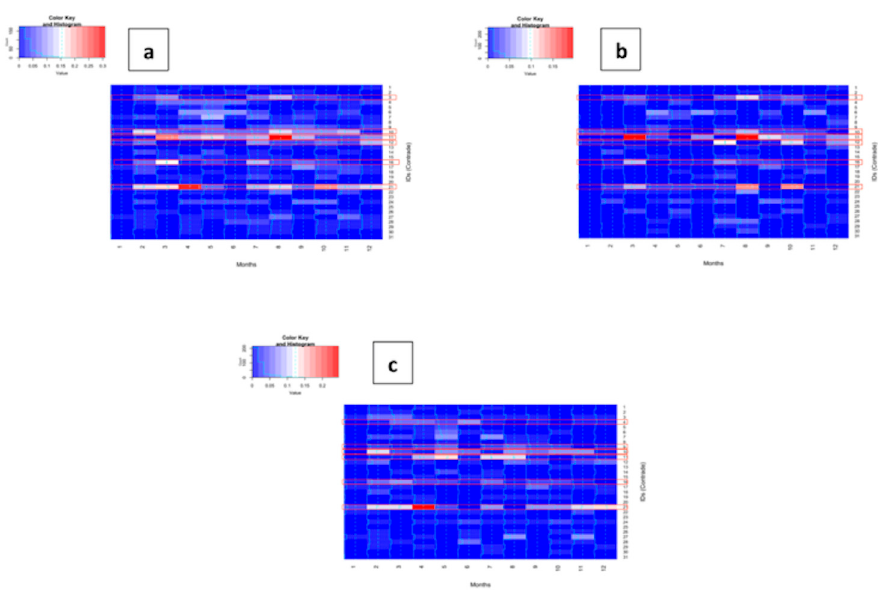
Figure 4. Heatmaps for all subjects ( a ), children ( b ), and adults ( c ). Horizontal red bands refer to the Contrade in which there were a high density of the events for the three groups of subjects.